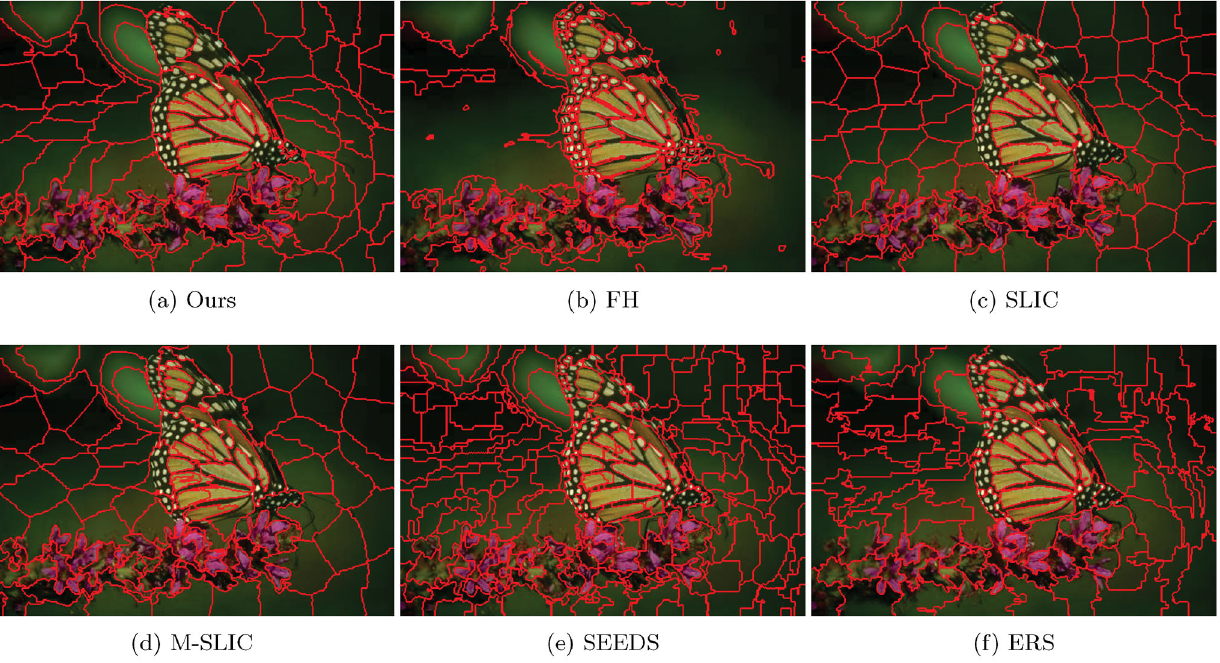
Fig. 6 Visual comparison of superpixel segmentation results using various algorithms, with 100 superpixels and m = 10. Our approach follows boundaries very well and at the same time produces compact